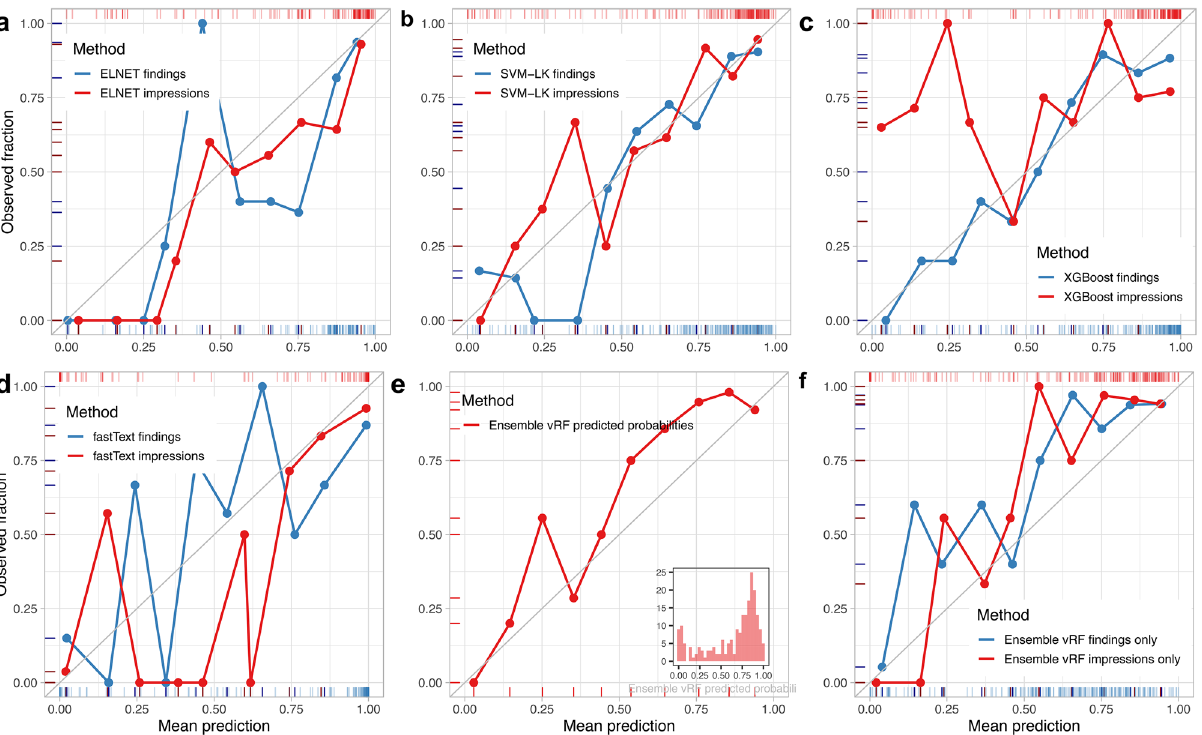
Figure 2. The calibration profiles of the best performing machine learning classifiers ( a – d ) fitted on the RadLex mappings and of the random forests meta/ensemble learner ( e , f ) fitted on the predicted probabilities of the ML-algorithms as features on all outer folds combined (N = 206). Probability estimates for each report by each ML classifier were recorded i.e. how likely it is that the predicted target label is “ASPECTS: yes”. The reliability of these predictions can be assessed visually on calibration plots. Calibration curves are created by grouping reports into discrete bins based on their assigned probability estimates by the ML-model. Thus, the probability space [0–1] gets discretized into bins (i.e. 0–0.1, 0.1–0.2, …, 0.8–0.9, 0.9–1.0; grey grid). The points represent the mean predicted probability (x-axis) and the observed fraction (y-axis) of true (“yes”) labels for the subset of reports falling in that respective range. For ideally calibrated models, the mean predicted probability and observed fraction should be identical within each bin, hence the calibration curve would lie on the diagonal (grey line). Rug plots (blue lines, findings; red lines, impressions) indicate the axis-values of the aforementioned aggregated bin measures (thick lines) and probability estimates of single reports (thin lines). ELNET ( a ) was more suitable for the impressions (red) particularly in the 0.50–0.75 range, corresponding to its top 3 ranked accuracy. Linear kernel SVMs ( b ) showed well-calibrated estimates for the 0.50–1.0 probability domain for both the findings (blue) and impressions (red). XGBoost ( c ) presented an almost ideal calibration curve on the findings (blue) while being the most accurate ML classifier (Table 2). FastText ( d ) achieved the highest overall accuracy when trained on the impressions (red) with partly well-calibrated estimates (0.75–1) but it was poorly calibrated on the findings (blue). The RF meta/ensemble learner ( e ) showed a reasonably well-calibrated